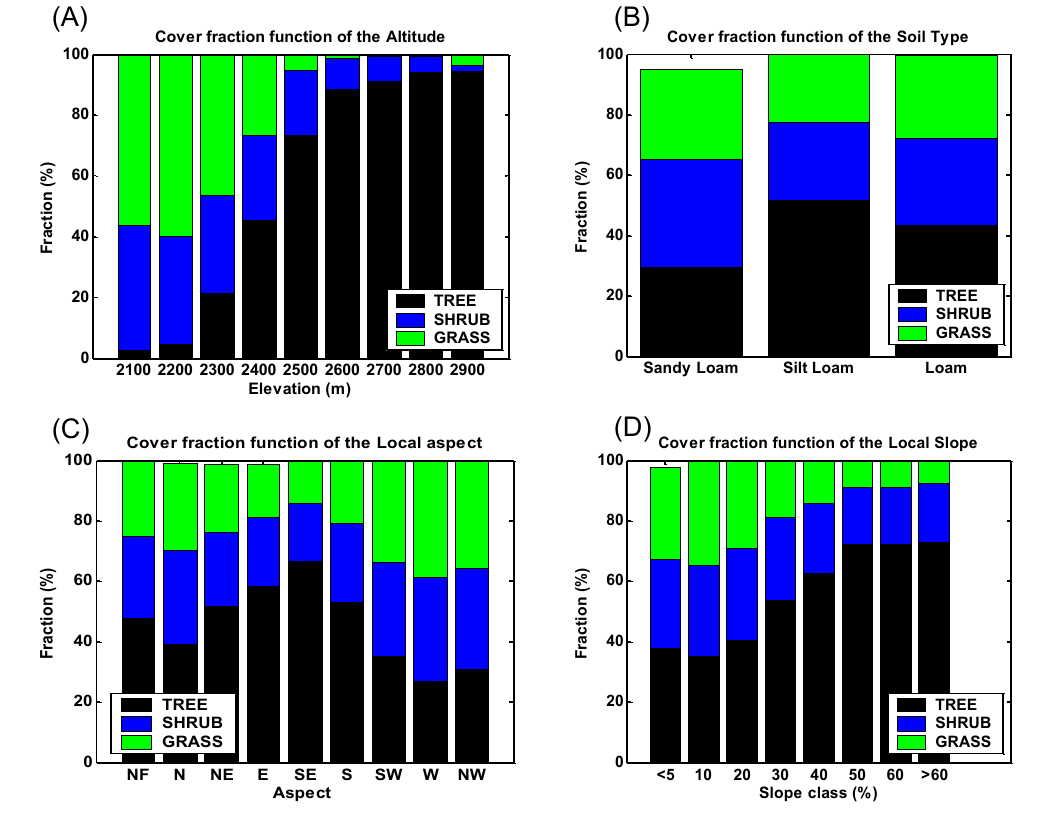
Figure 2. Land cover fractions of the Rio Salado basin: ( A ) as a function of the altitude (m); ( B ) for the three soil types identified in the basin; ( C ) as a function of the basin aspect; and ( D ) as a function of slope